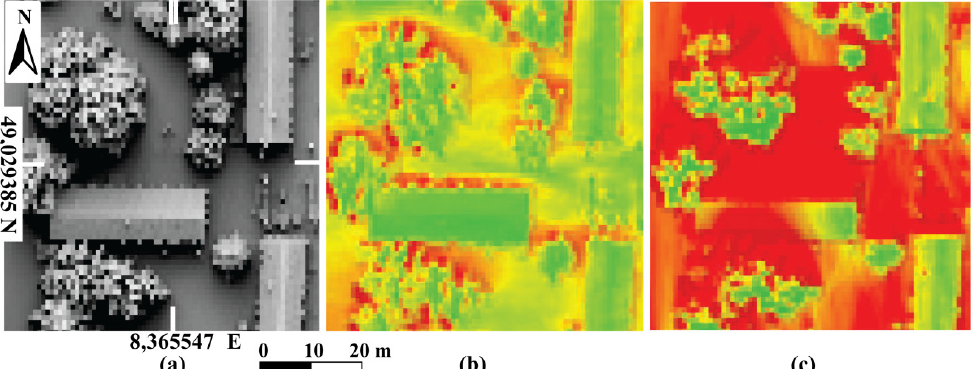
Figure 2. Color-coded shadowing effects on the roof areas of the Karlsruhe (GER) test site (subset) for different months (green = no effects, red = strong effects). ( a ) DSM; ( b ) June; ( c ) December. Copyright: Grundlage: Auszug aus dem Digitalen Oberflächenmodell—© Landesamt für Geoinformation und Landentwicklung Baden-Wuerttemberg (www.lgl-bw.de), 04.12.2014, Az.: 2851.3-A/854.